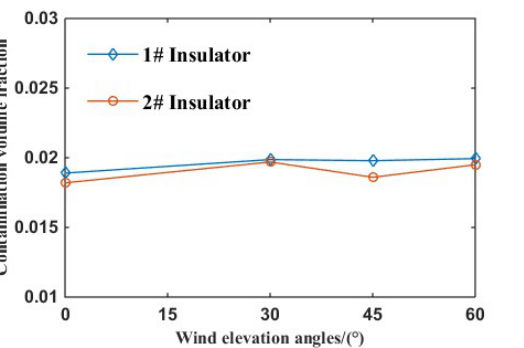
Figure 38. Contamination volume fractions of insulator under different Wind elevation